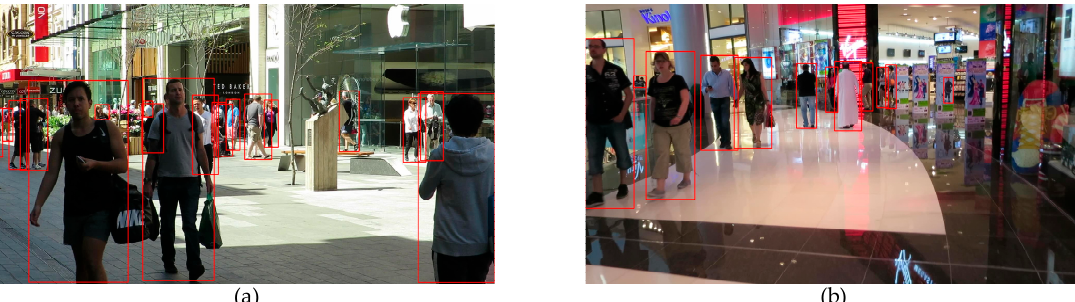
Figure 5. Examples of object detection results. ( a ) MOT-16-08. ( b ) MOT-16-12.